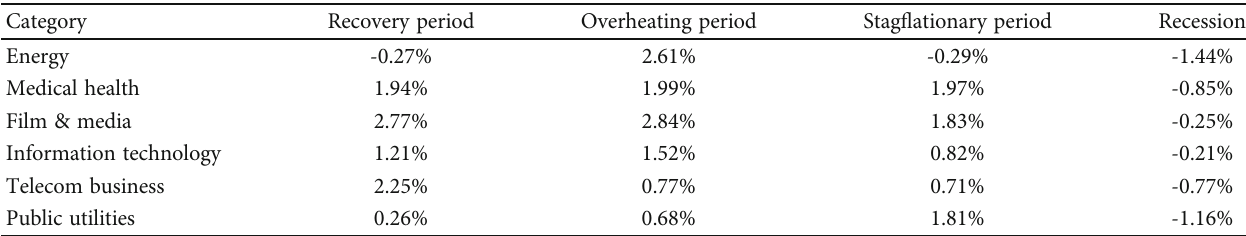
Table 8: Monthly average returns for each sector index over di ff erent economic cycles.